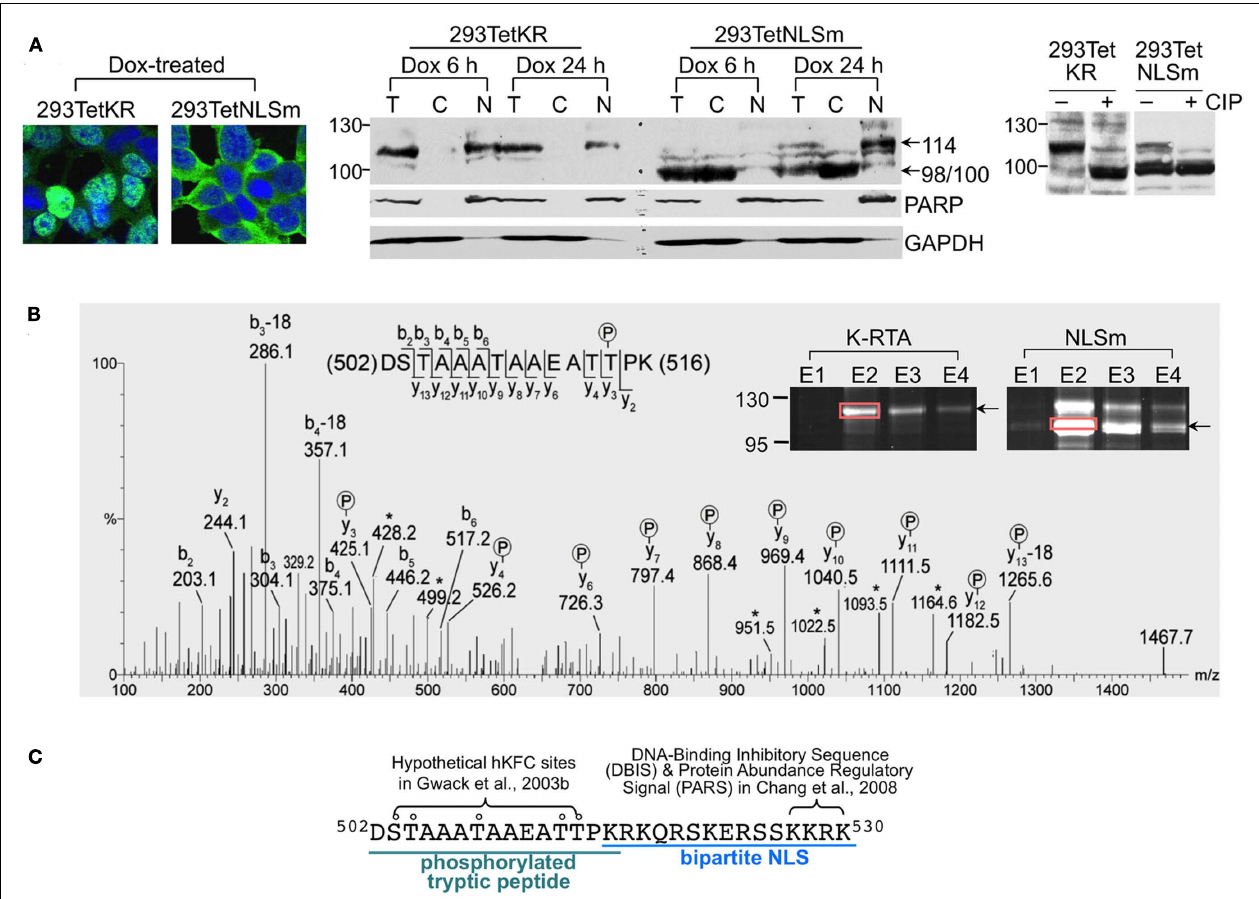
45min followed byWestern blot analysis. (B) MS/MS spectrum on [M + 2H] 2 + ( m / z 743.31) ion for the one phosphorylation-modified peptide DSTAAATAAEATTPK from K-RTA (rectangle).The product ion y 3 that carries a phosphate indicated thatThr-514 was phosphorylated but its low intensity among other background/unassigned peaks does not preclude the alternative Thr-513 site. A single phosphorylation on either site was unambiguously supported by additional phosphorylated y ions. Product ions marked with starts resulted from elimination of H 2 O. Of note, the same spectrum was observed for 100kDa NLSm (not shown). (C) Summary of various features identified in amino acids